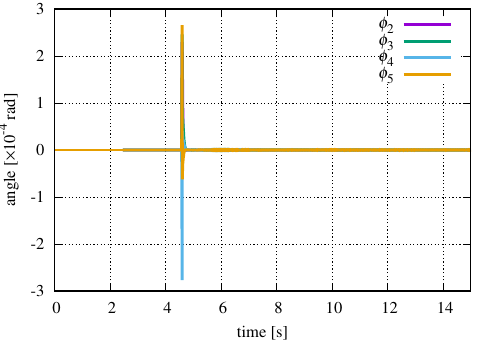
Figure 21. Case 2: Time variation of the relative angles.